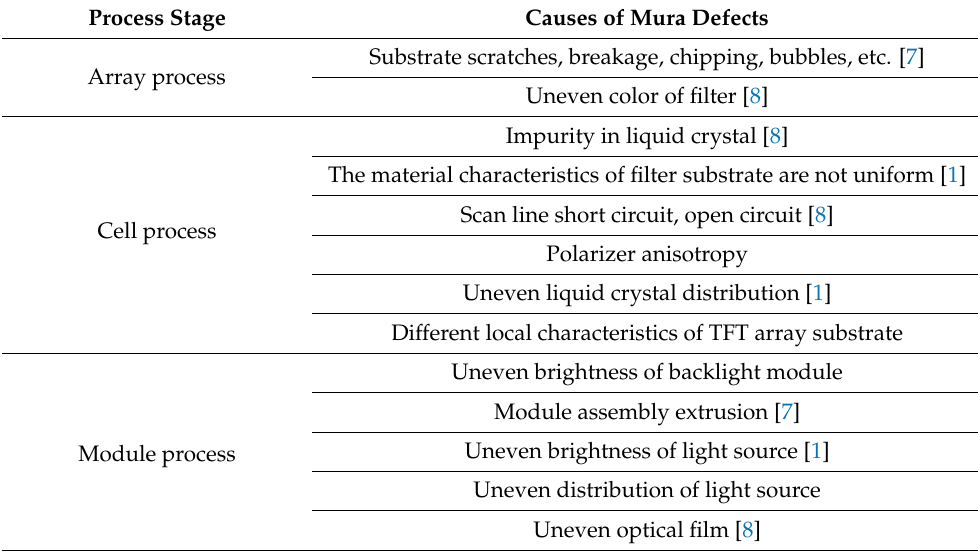
Table 1. Common causes of Mura defects in the manufacturing